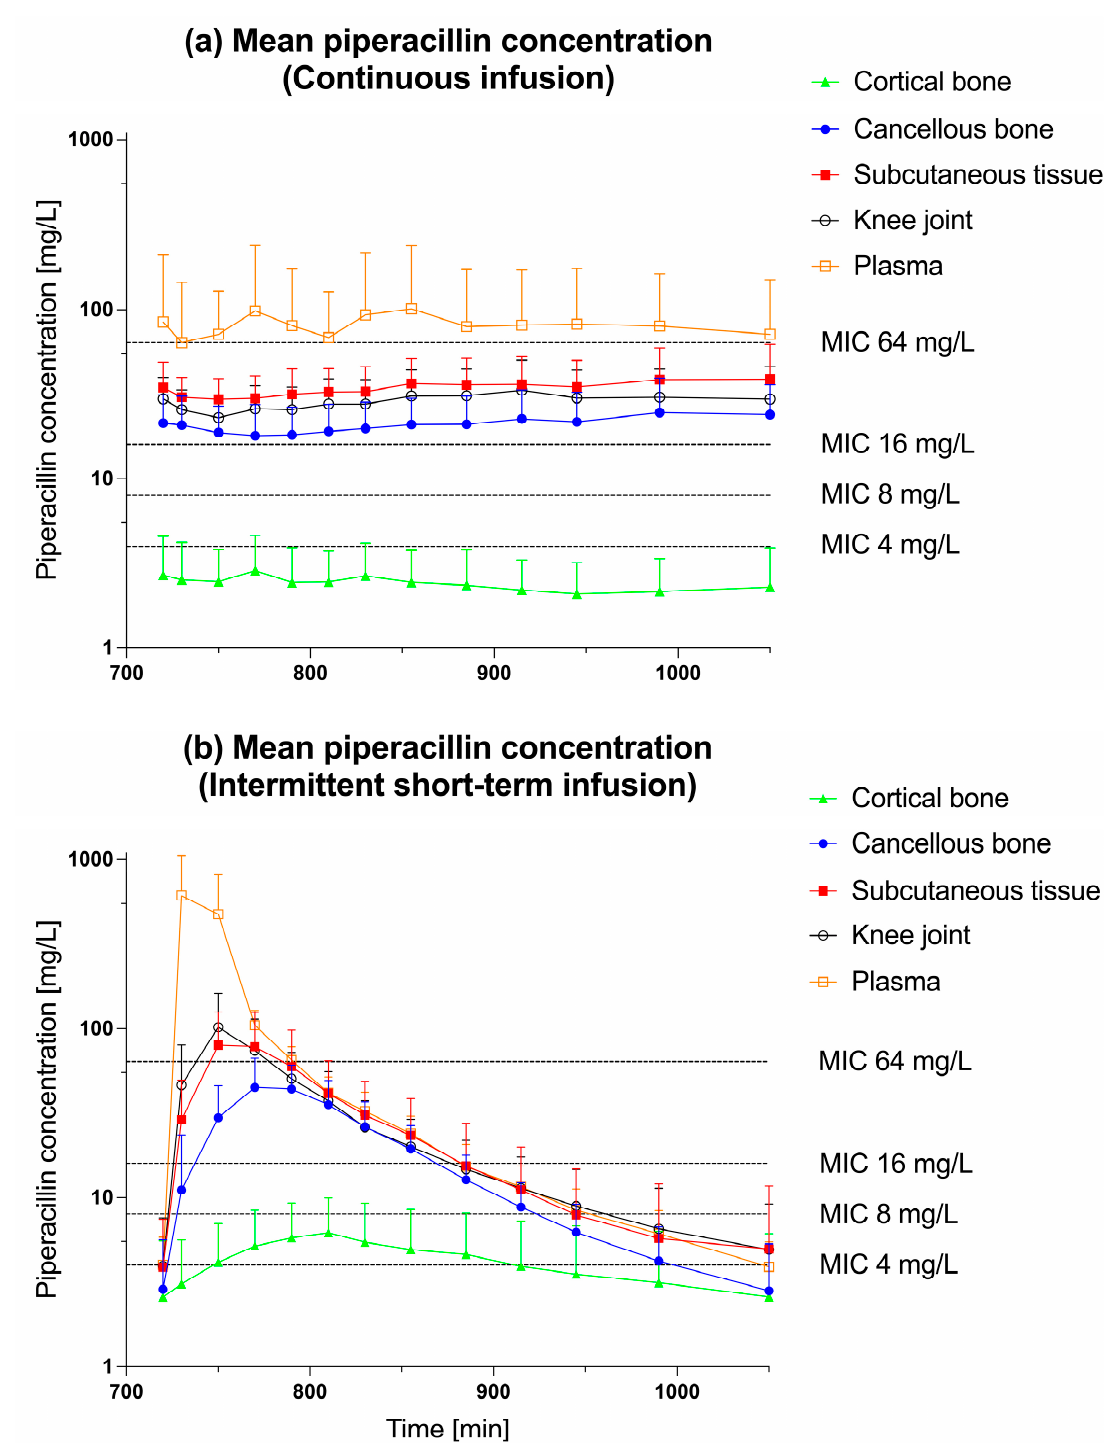
Figure 1. Mean piperacillin concentration–time profiles on log scale following continuous infusion ( a ) and intermittent short-term infusion ( b ). MIC = 4, 8, 16, and 64 mg/L values are inserted for target illustration by dotted lines. Error bars represent 95% CI; upper limit is shown.